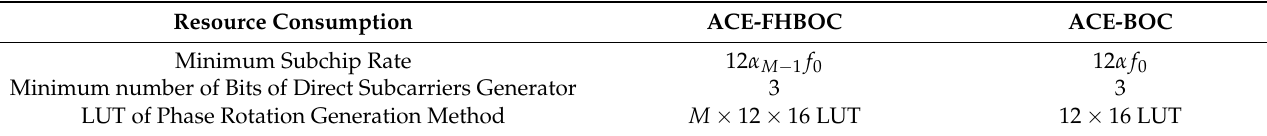
Table 2. Generation complexity comparison summary.